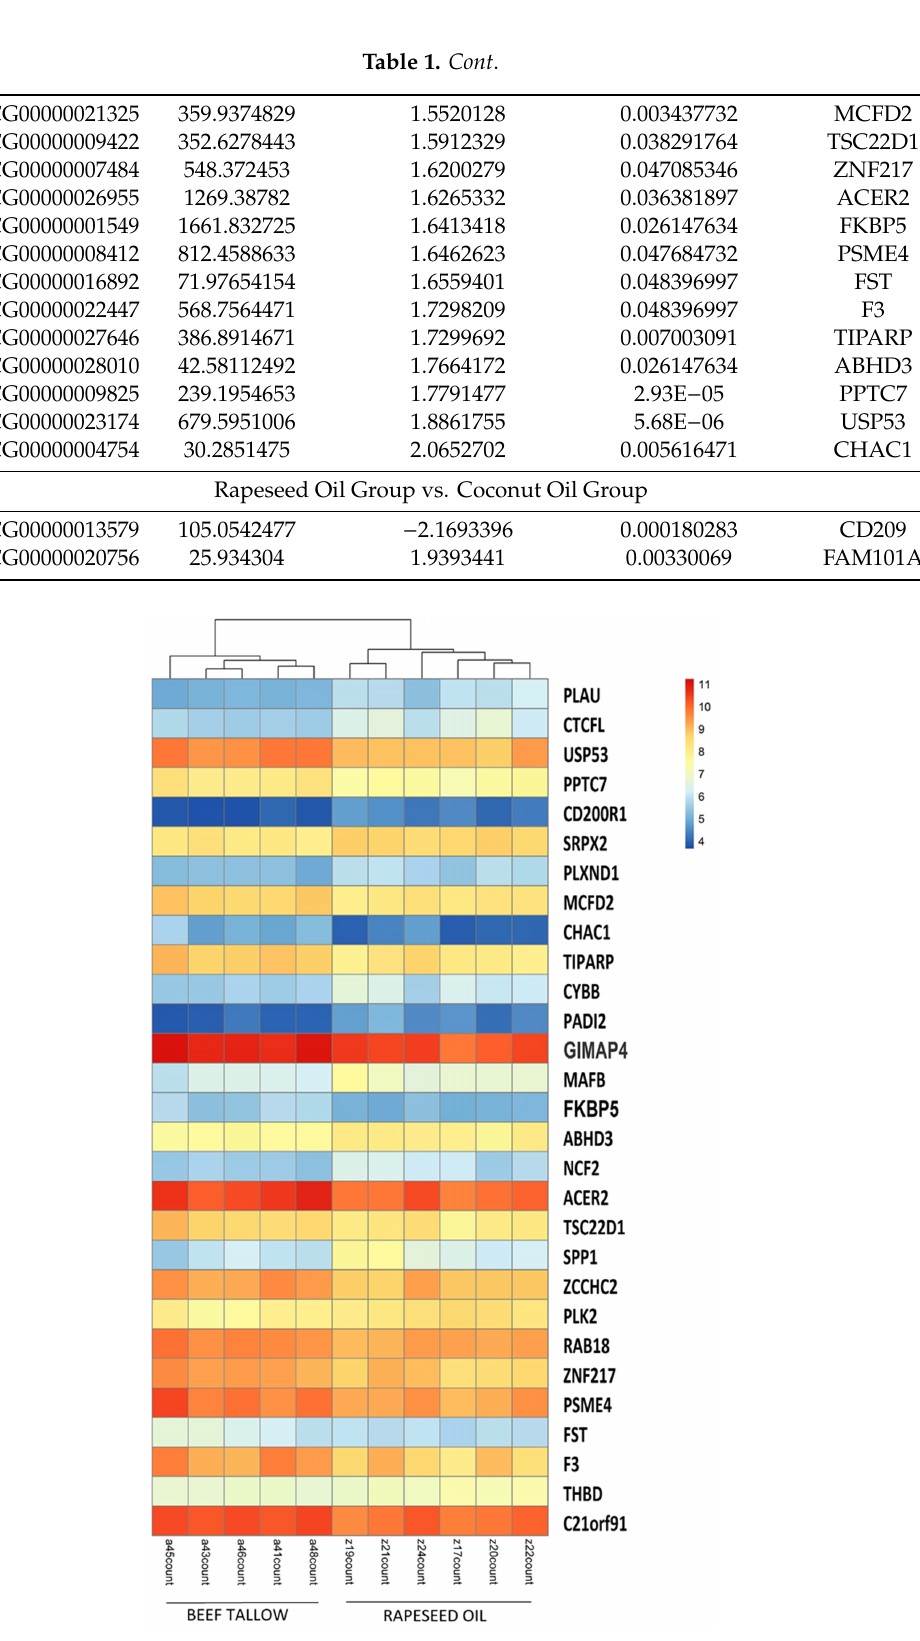
Figure 2. Hierarchical clustering of samples based on the expression level of differentially expressed genes (DEGs). Table 1. Differentially expressed genes identified in the study.